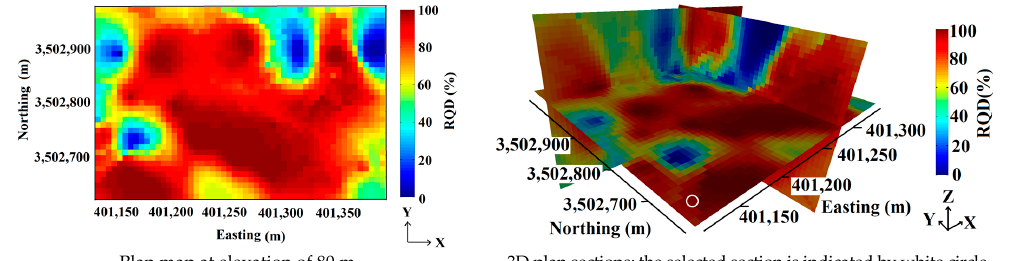
Figure 10. Multi-Gaussian kriging of RQD, high quality rocks are distributed in the middle of the region.